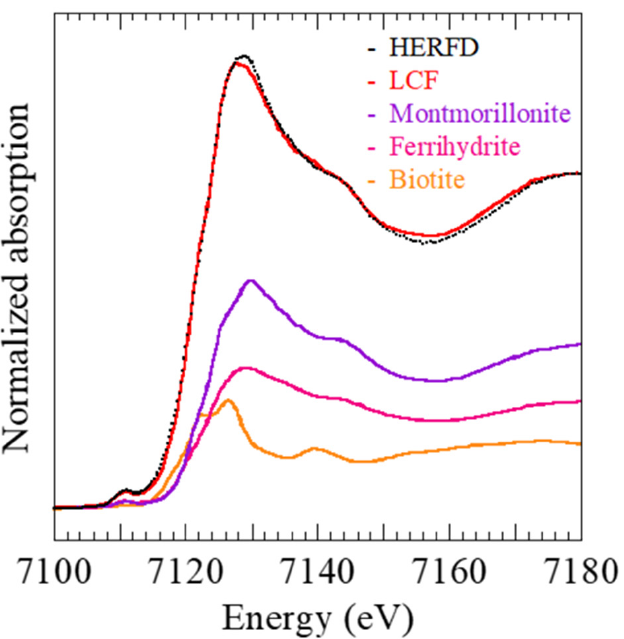
Figure 3. Fe K-edge XANES spectra for Fe in MT21-S2 (black dots: measured spectra; red solid curve: fitted spectra).